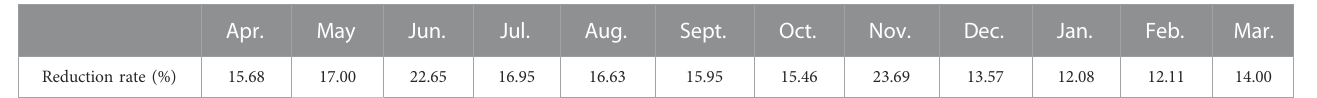
TABLE 8 CO 2 emission reduction